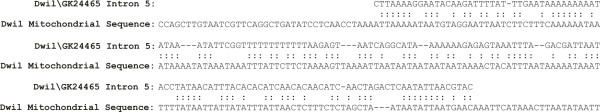
Intron gain by DSBR. Alignment between the reverse complement of a gained intron in Dwil\GK24465 and a segment of D. wil's mitochondria (e-value = 0.032, coverage = 99%). The best score produced by randomly shuffling and realigning these sequences 1, 000 times was significantly lower (Pearson chi-square test, p < 0.05) than the score between the original sequences.